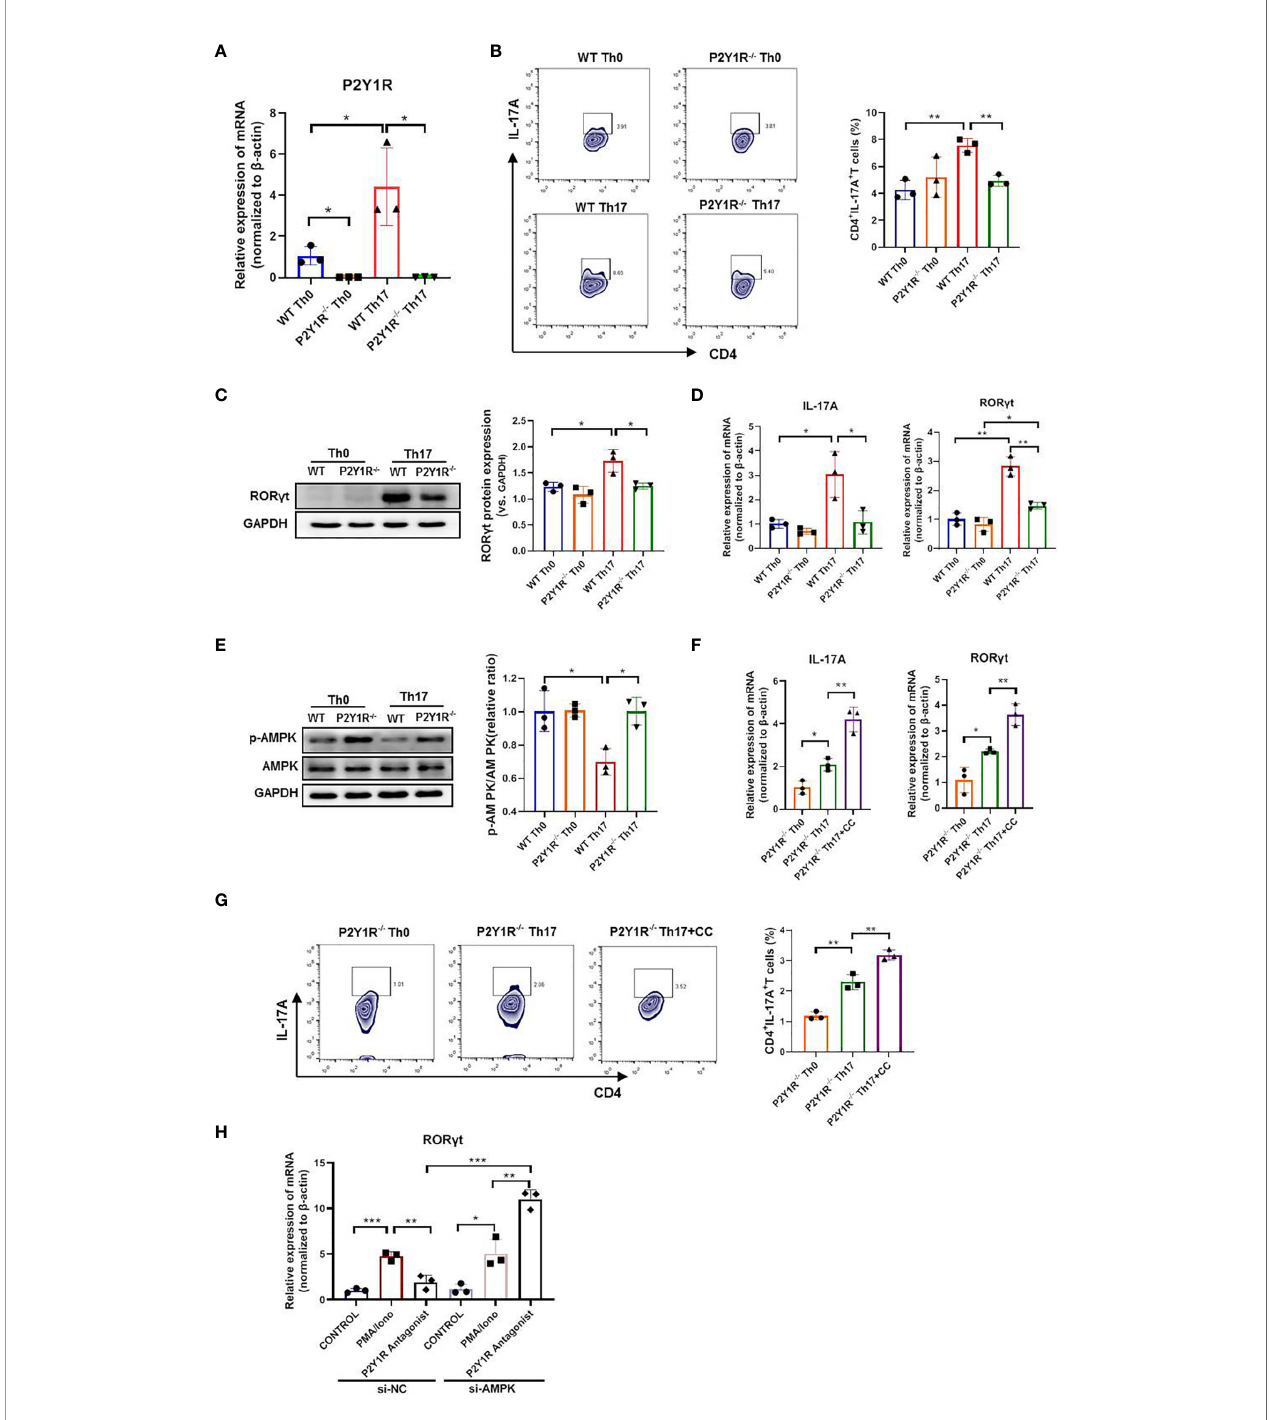
FIGURE 4 | De fi ciency of P2Y1R impairs Th17 cell differentiation via AMPK activation in vitro . (A) mRNA expression of P2Y1R on Th0 and Th17 polarized CD4 + T cells derived from P2Y1R -/- mice and WT mice. (B) P2Y1R de fi ciency suppresses Th17 differentiation in vitro . (C) P2Y1R de fi ciency decreases protein expression of ROR g t in Th17 polarized CD4 + T cells. (D) P2Y1R de fi ciency decreases the mRNA expression of ROR g t and IL-17A in Th17 polarized CD4 + T cells. (E) P2Y1R de fi ciency induces AMPK phosphorylation of Th17 polarized CD4 + T cells. (F) Blockage of AMPK increases the mRNA expression of ROR g t and IL-17A in Th17 polarized CD4 + T cells derived from P2Y1R -/- mice. (G) Blockage of AMPK increases Th17 differentiation of naïve CD4 + T cells derived from P2Y1R -/- mice in vitro . (H) Silence of AMPK in PMA and ionomycin-induced EL4 cells reversed the inhibitory effect of P2Y1R antagonist MRS2179 on ROR g t mRNA expression. Data from are expressed as mean ± SEM of three independent experiments. *p < 0.05, **p < 0.01 and ***p <